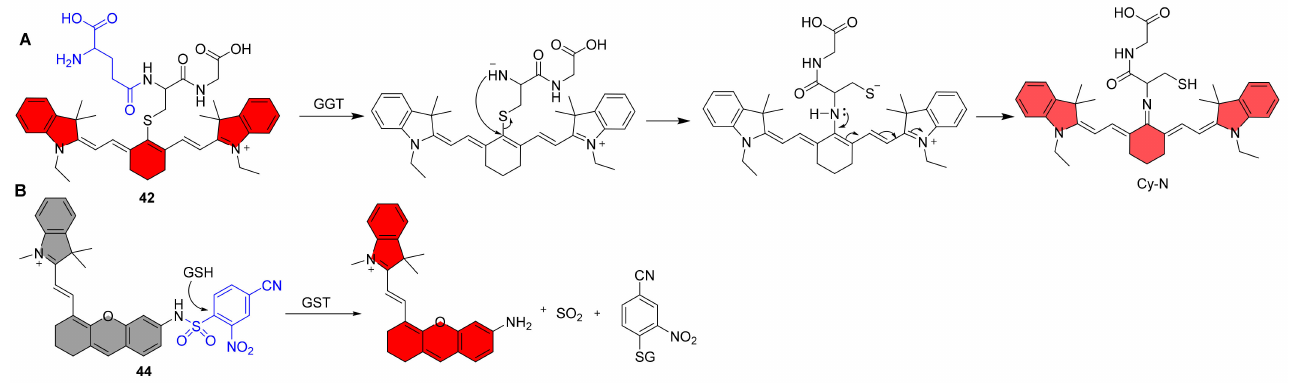
Figure 6. Recognition mechanism of probe 42 and 44